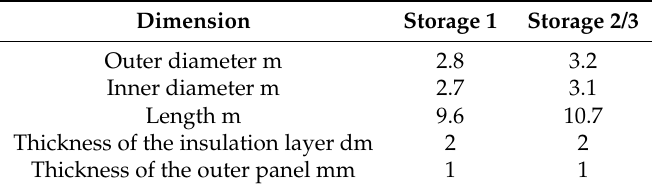
Figure 7. Simplification of the storage vessel geometry. Table 1. Dimensions of the Ruths steam storage